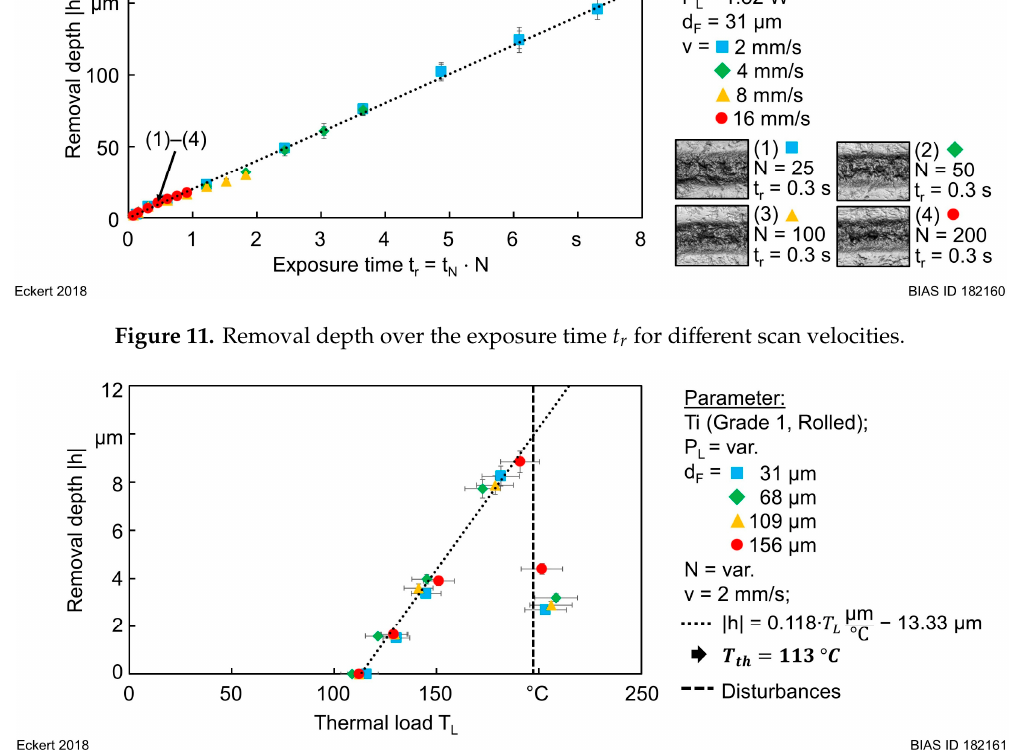
ff erent focus L for di